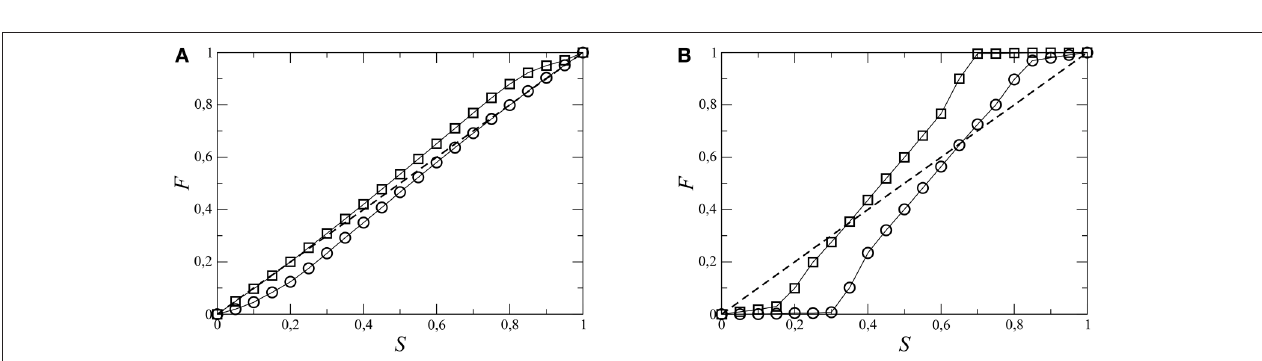
FIGURE 4 | Distribution of fluid bubbles (top row) and local flow rates (bottom row) in steady state in a network of 64 × 64 links with oil saturation S = 0.3 and Ca = 10 − 2 . The left column is for the steady state in a oil-wet network and the right column is the new steady state after wettability alteration takes place. In (A,B) , the oil bubbles are drawn in black. In (C,D) , the normalized local flow-rates q i / q max are drawn in gray scale.